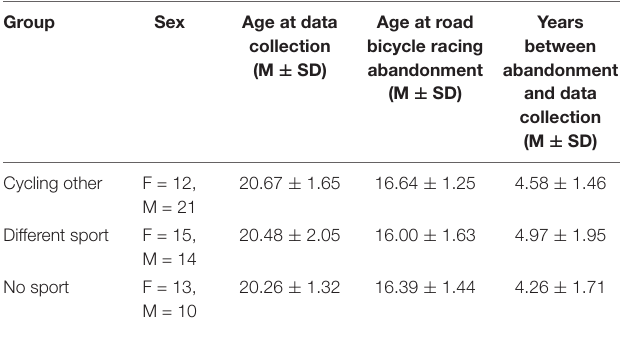
TABLE 1 | Descriptive data of the three groups of